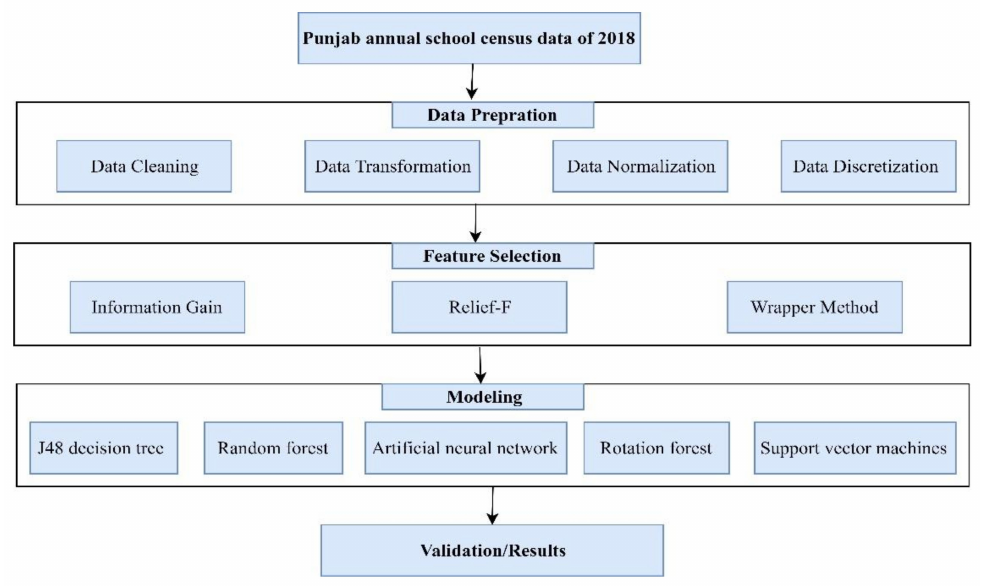
Figure 1. Proposed